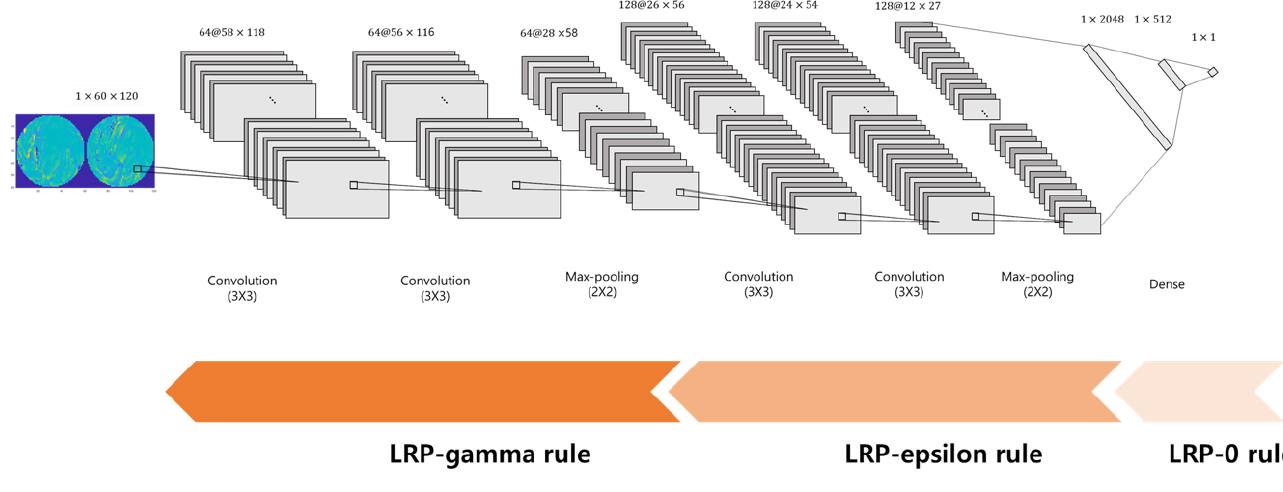
Figure 1. The structure of the CNN classifier for the discrimination of RLS patients and normal controls.